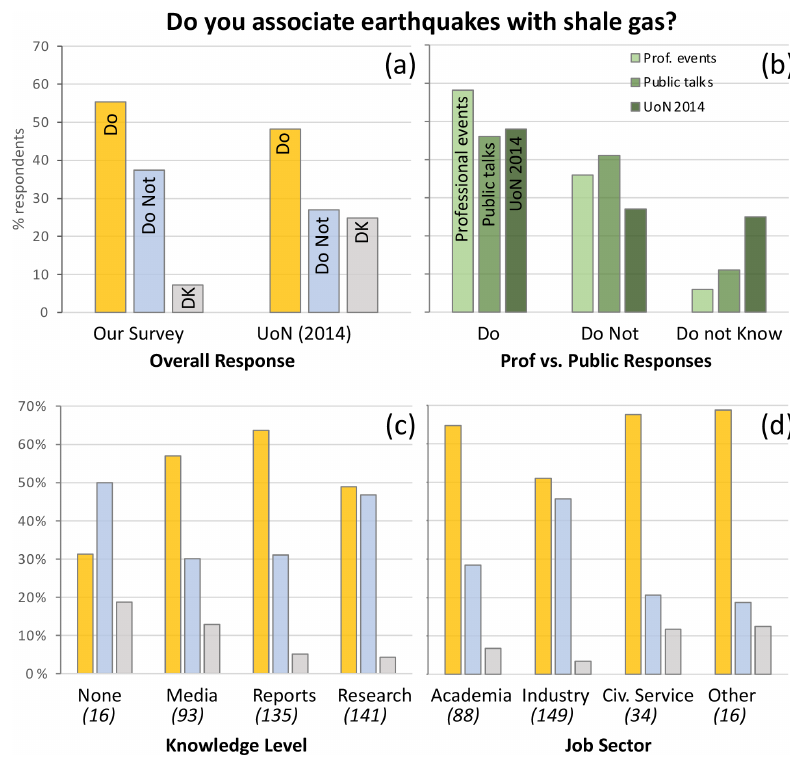
Figure 3. (a) Comparing the results of our surveys with UK-wide results from 2014 (UoN 2014; O’Hara et al., 2014), we find that, while results for those who “do” associate shale gas with earthquakes (orange) for both surveys are similar, our survey results have more “do not” (blue) and much fewer “do not know” answers (grey). (b) Participants from professional fora (conferences and events – pale green) associate earthquakes with shale gas more than participants from public talks on shale gas (green). Results are compared to UK-wide results from 2014 (UoN 2014; O’Hara et al., 2014; dark green). (c) To gauge knowledge levels of our survey participants, we asked respondents to select where they source their information from about shale gas, which we used as a proxy for their level of knowledge, with “research papers” indicating the greatest knowledge and “no previous information” indicating the least prior knowledge. There is no overall trend to the results, suggesting that answers are not simply determined by knowledge level. In fact, those who obtain information from research present an equally polarised response, which is different to information from reports and the media, where the dominant answer is that earthquakes are associated with shale gas. The only group to report that shale gas is not associated with earthquakes is the small sample of respondents that obtained no information about shale gas prior to attending the event where they completed the survey. (d) The majority (83%) of participants recruited at conferences and events ( n = 272) represent industry and academia (public participants were not asked about their job sector). We observe some differences in closed-question responses between the different sectors; while the majority of participants from academia, the civil service, and other sectors predominantly report that earthquakes are associated with shale gas, industry participants are split almost 50:50 between those who do and do not associate shale gas with earthquakes. Very few of those from industry and academia ( ∼ 5%) answer that they do not